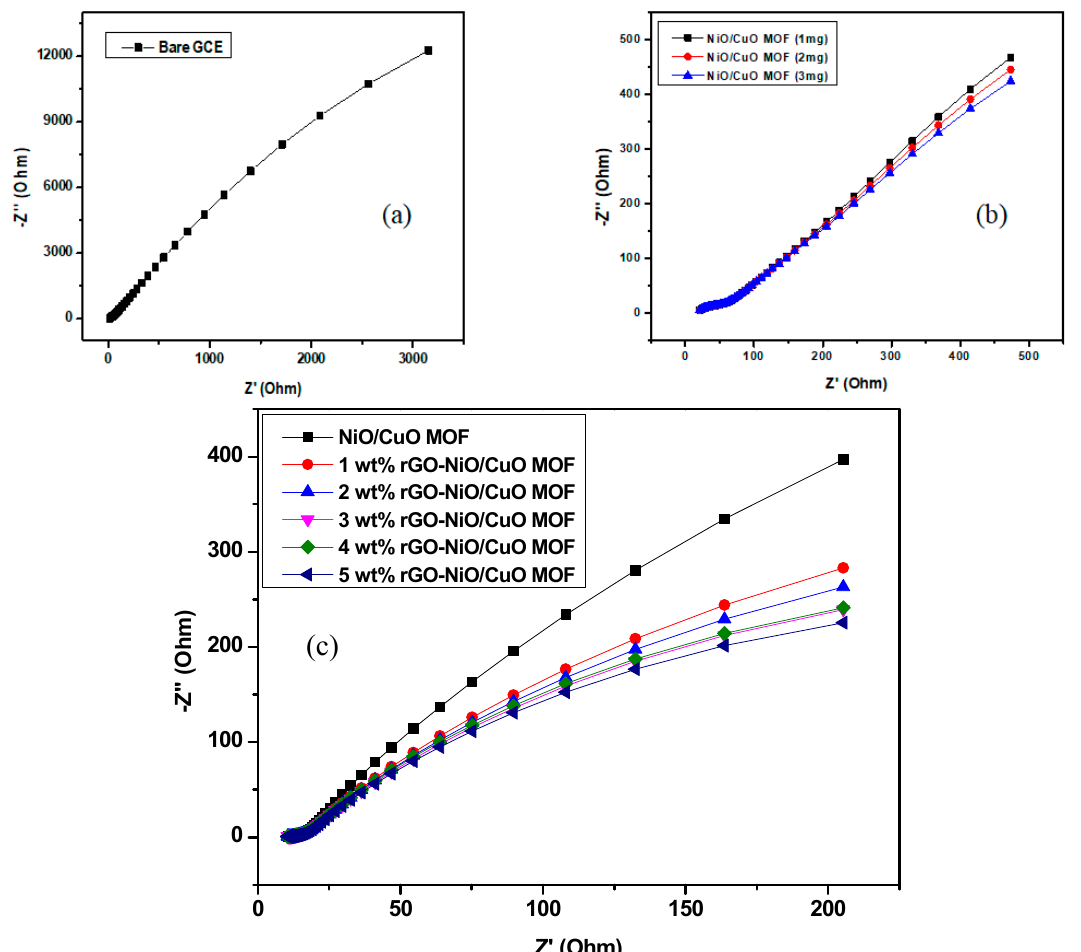
Figure 8. Nyquist plots of ( a ) bare GCE ( b ) NiO / CuO MOF at di ff erent concentrations ( c ) NiO / CuO MOF and its composites with 1 wt%, 2 wt%, 3 wt%, 4 wt%, and 5 wt% rGO in 3 M methanol and 1 M NaOH at E = 0.5 V.